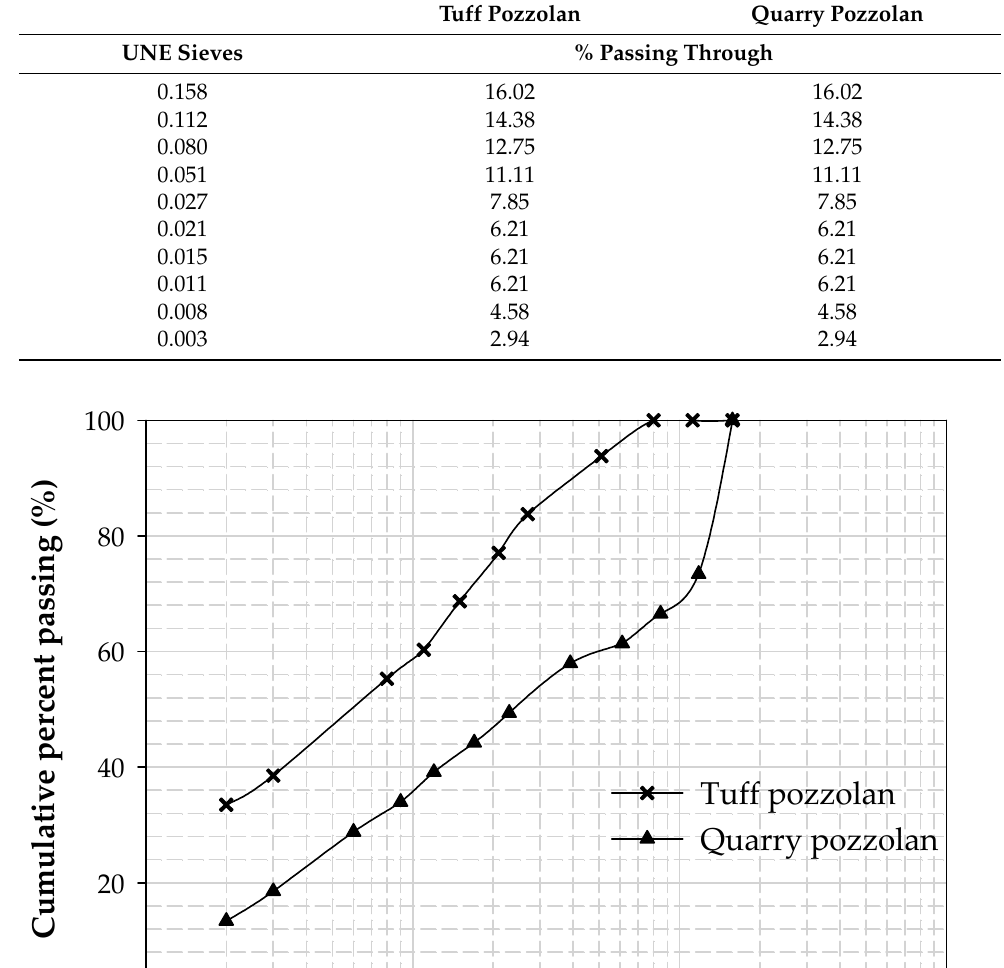
Table 6. Flexural strength, compressive strength, and resistance activity index of the additives in the reference cement. Sample